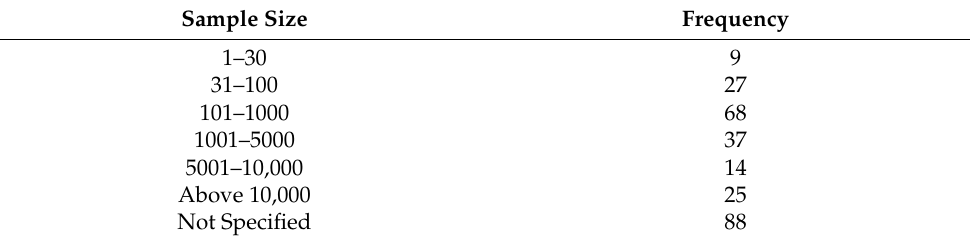
Table 4. Range of sample sizes used in all the